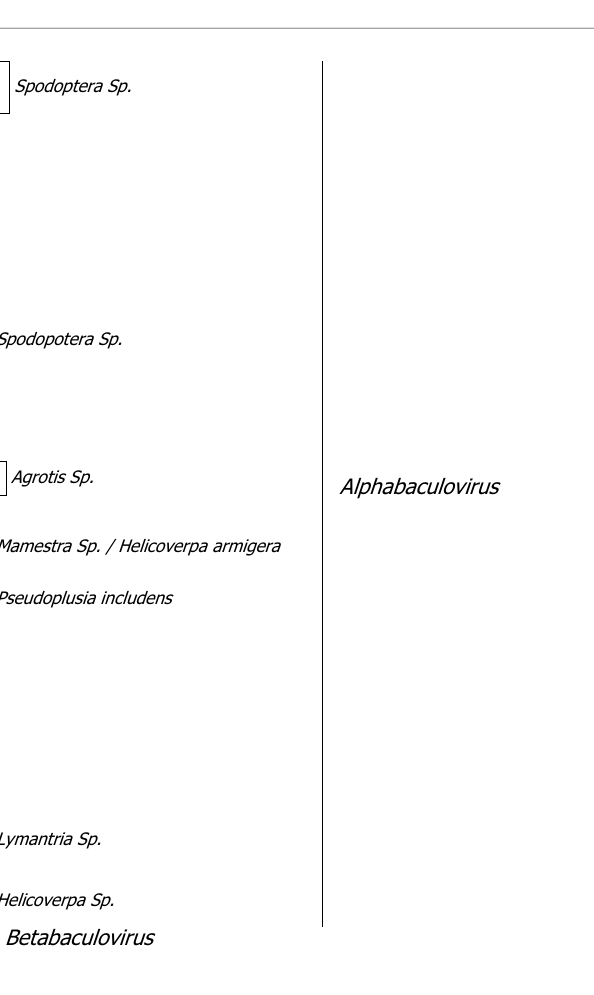
Fig. 3 Baculovirus phylogeny based on Minimum Evolution (ME) method of amino acid sequences of 38 core genes of different NPV. Translated amino acid sequences of each core gene were separately aligned, and alignments were concatenated using Geneious 8. The consensus tree was obtained by a heuristic search with 500 bootstrap replicates. The Model is the JTT model (Jones et al. 1992) with a uniform rate among site and without invariant site. Bootstrap values (> 50%) are shown at each node. Only Alphabaculovirus group II is given in detail. Alphabaculovirus group I and Betabaculovirus were reduced. Betabaculoviruses represented with only CpGV-M and SpliGV-K1 for this analysis were used as